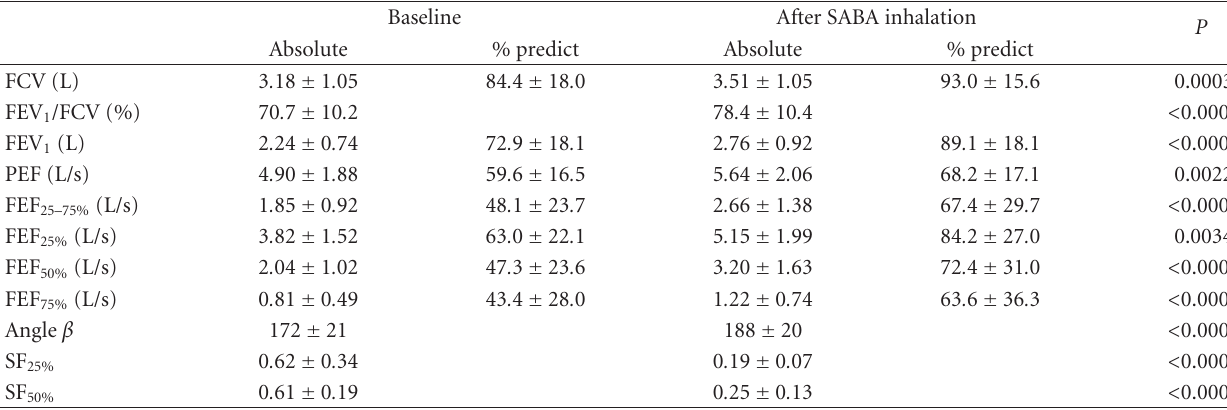
Table 1: Spirometric parameters in patients with wheeze and bronchial reversibility.